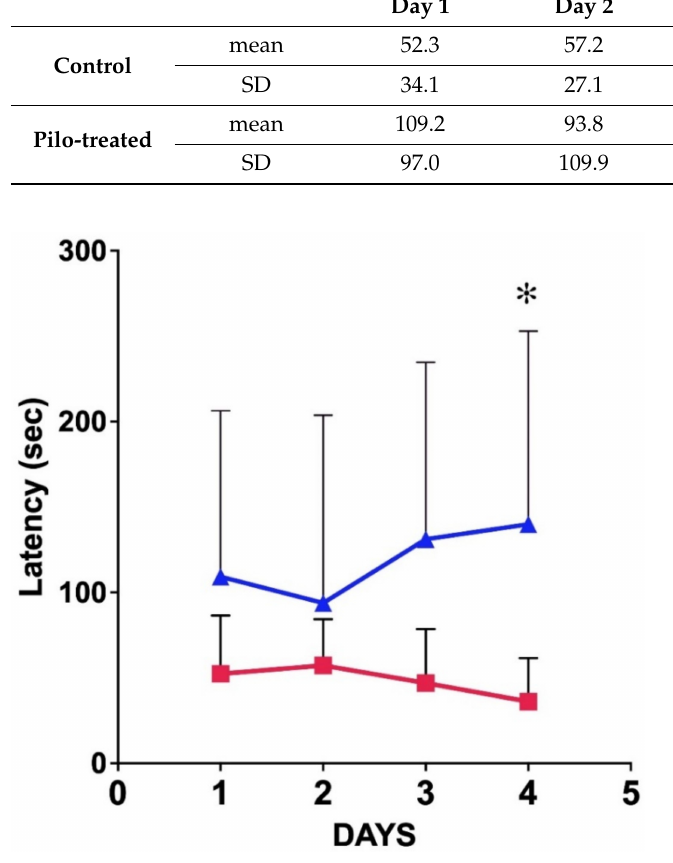
Figure 9. Performance of control (red) and PT (blue) animals in the Barnes maze. Mean latencies of the 9 control and 9 PT animals were plotted against time. The standard error of the mean is depicted at each point. It is clear that the controls showed improved performance as a function of time, while the performance of the PT animals became worse. The two-way ANOVA proved that the variances of the mean latencies in the groups were significantly different (asterisk: p = 0.0438; alpha = 0.05; 95% CI of the difference: from − 138.5 to −